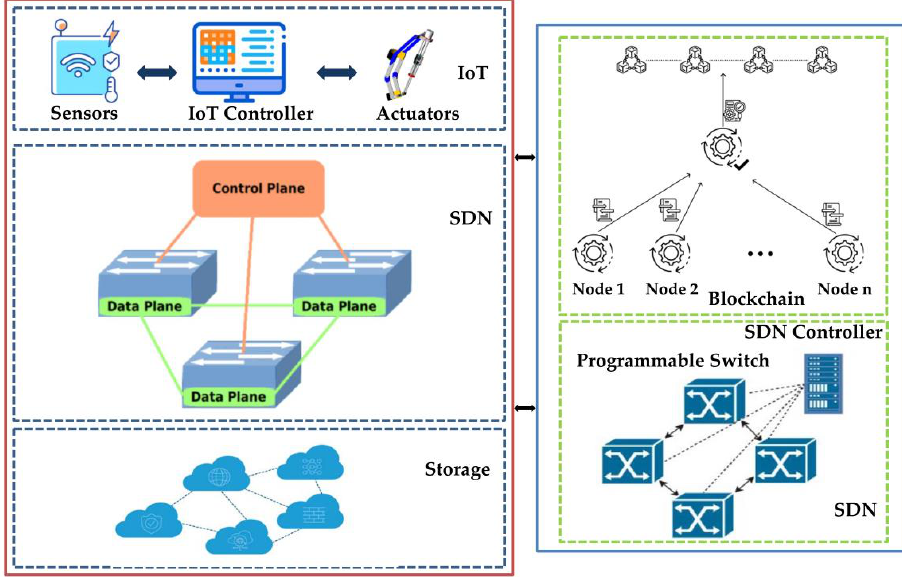
Figure 3. The proposed framework of blockchain enabled SDN-IoT network.